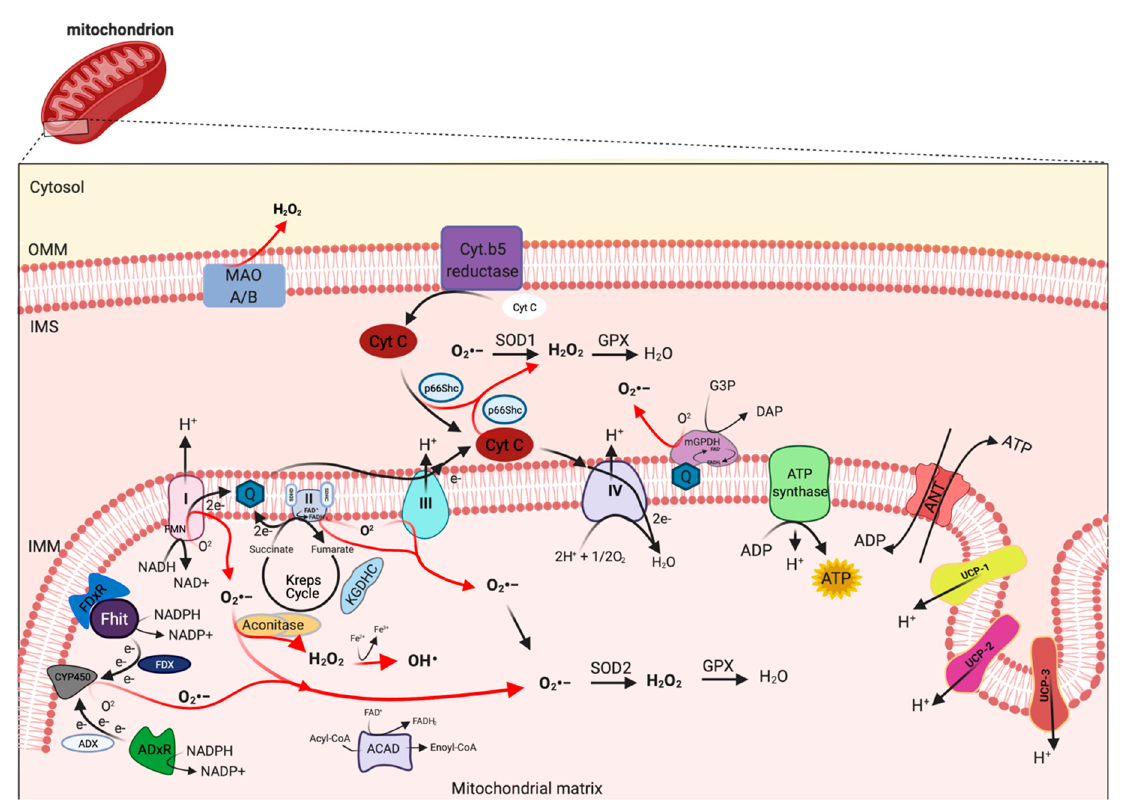
Figure 1. Mitochondrial sites of ROS production. Mitochondrial complex I and III of respiratory chain are the principal sites of O 2• − production within a cell, which can be converted to H 2 O 2 by superoxide dismutase (SOD1 and SOD2) enzymes. H 2 O 2 in turn is rapid neutralized to H 2 O and oxygen by glutathione peroxidase (GPX). However, other mitochondrial proteins, localized from OMM to matrix, may also contribute to mtROS production, including monoamine oxidase A and B (MAO A/B), cytochrome (Cyt.) b5 reductase, mitochondrial glycerol-phosphate dehydrogenase (mGPDH), p66Shc, Fhit with ferredoxin reductase (FDxR), adrenodoxin reductase (ADxR)-adrenodoxin (ADX)-cytochrome P450scc (CYP450) system, α -ketoglutharate dehydrogenases (KGDHC), acyl-CoA dehydrogenases (ACAD) and aconitase. This figure has been created with “BioRender.com.”.